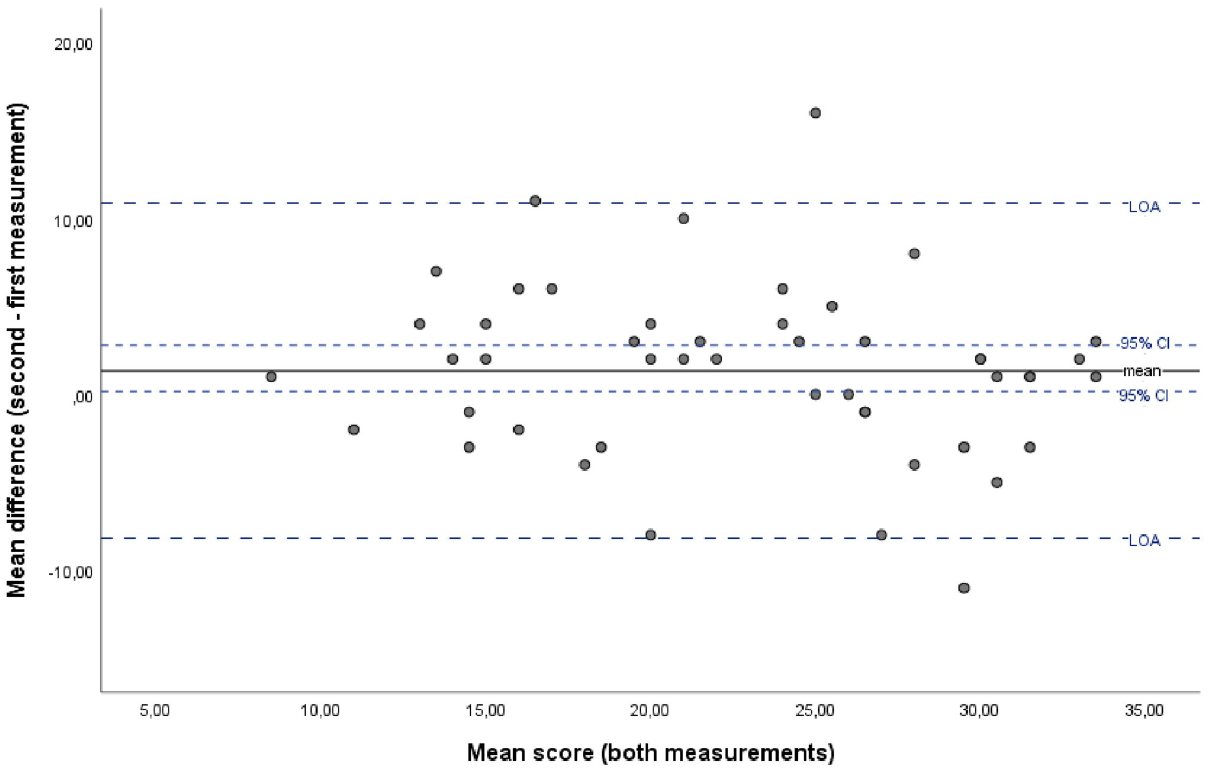
Fig 1. Bland Altman plot visualizing absolute agreement. CI = confidence interval; LOA = limits of agreement.